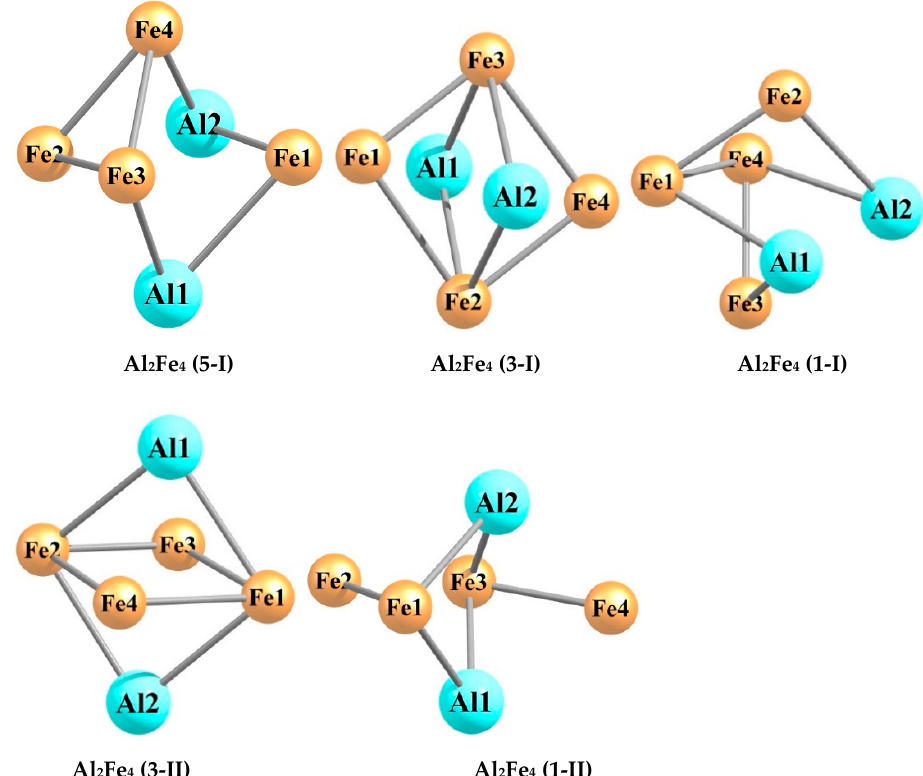
Figure 4. Molecular structures of the five most energetically stable Al 2 Fe 4 metal clusters. Table 8. Key structural parameters of the most stable Al 2 Fe 4 metal clusters.